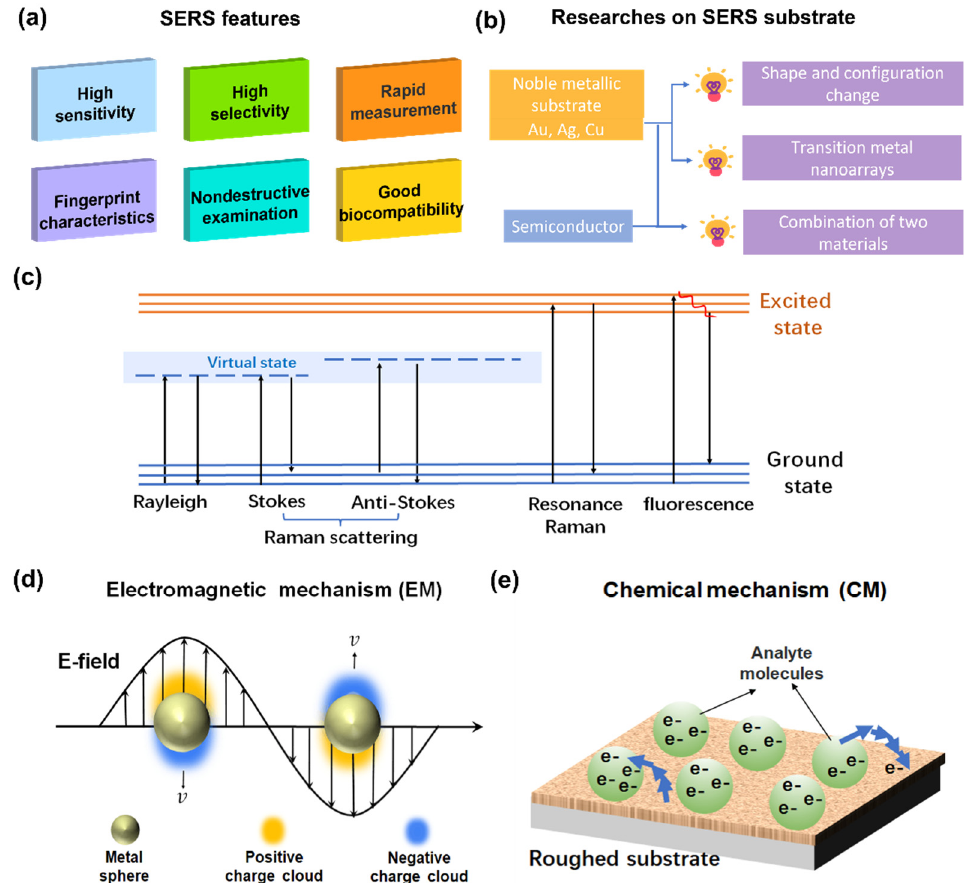
Figure 1. ( a ) Features of SERS; ( b ) development of research on SERS substrate; ( c ) schematic of Raman scattering; ( d ) EM: surface plasmon resonance on metal surface; ( e ) CM: charge transfer between analyte molecules and roughed substrate.